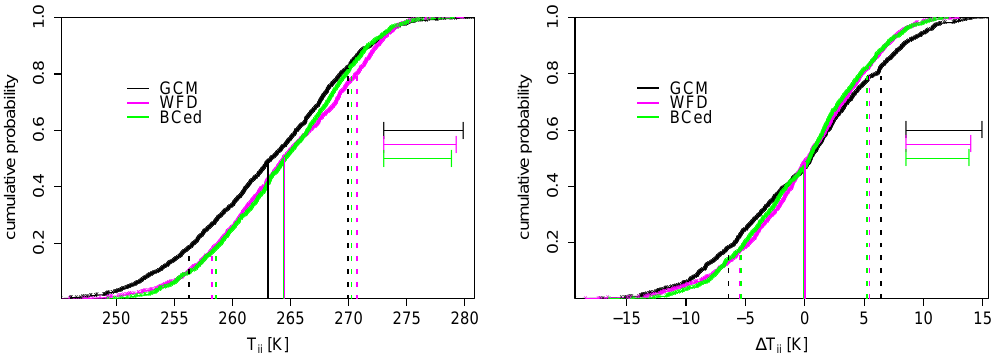
Fig. 3. Observational and simulated daily April temperature values during the reference period (left) and associated residual values (right) for example grid cell are shown as normalised cumulative sum. The vertical lines refer to related mean (solid) and mean ± standard deviation (dashed). Horizontal bars are for comparison of the standard deviation.